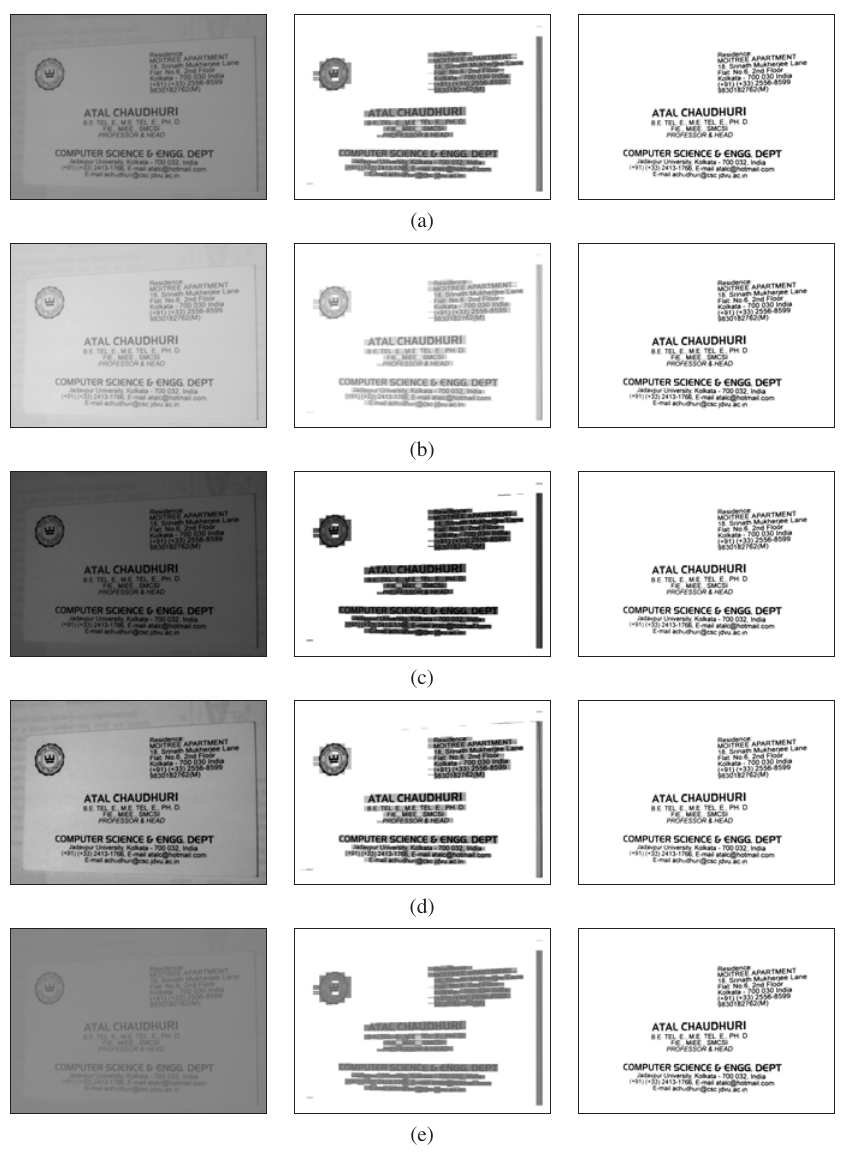
Figure 5. Extracted text regions and binarized images after applying various effects on an original image. (a) On the camera captured image. (b) After increasing bright- ness by 25%. (c) After decreasing brightness by 25%. (d) After increasing contrast by 25%. (e) After decreasing contrast by